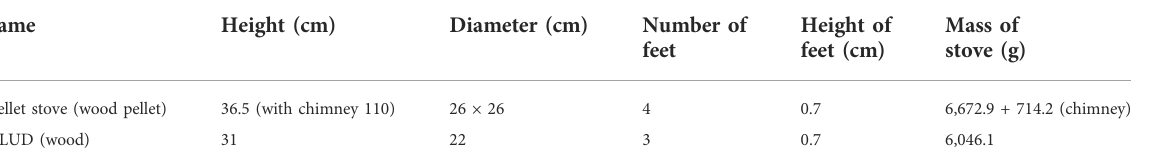
TABLE 2 Dimensions of the Chinese